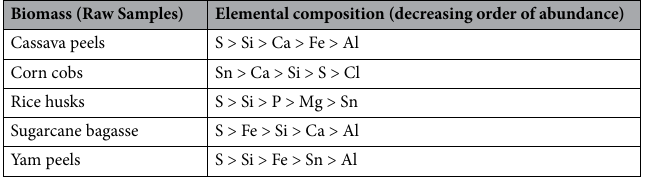
Table 2. Major inorganic constituents of the lignocellulosic biomass in this